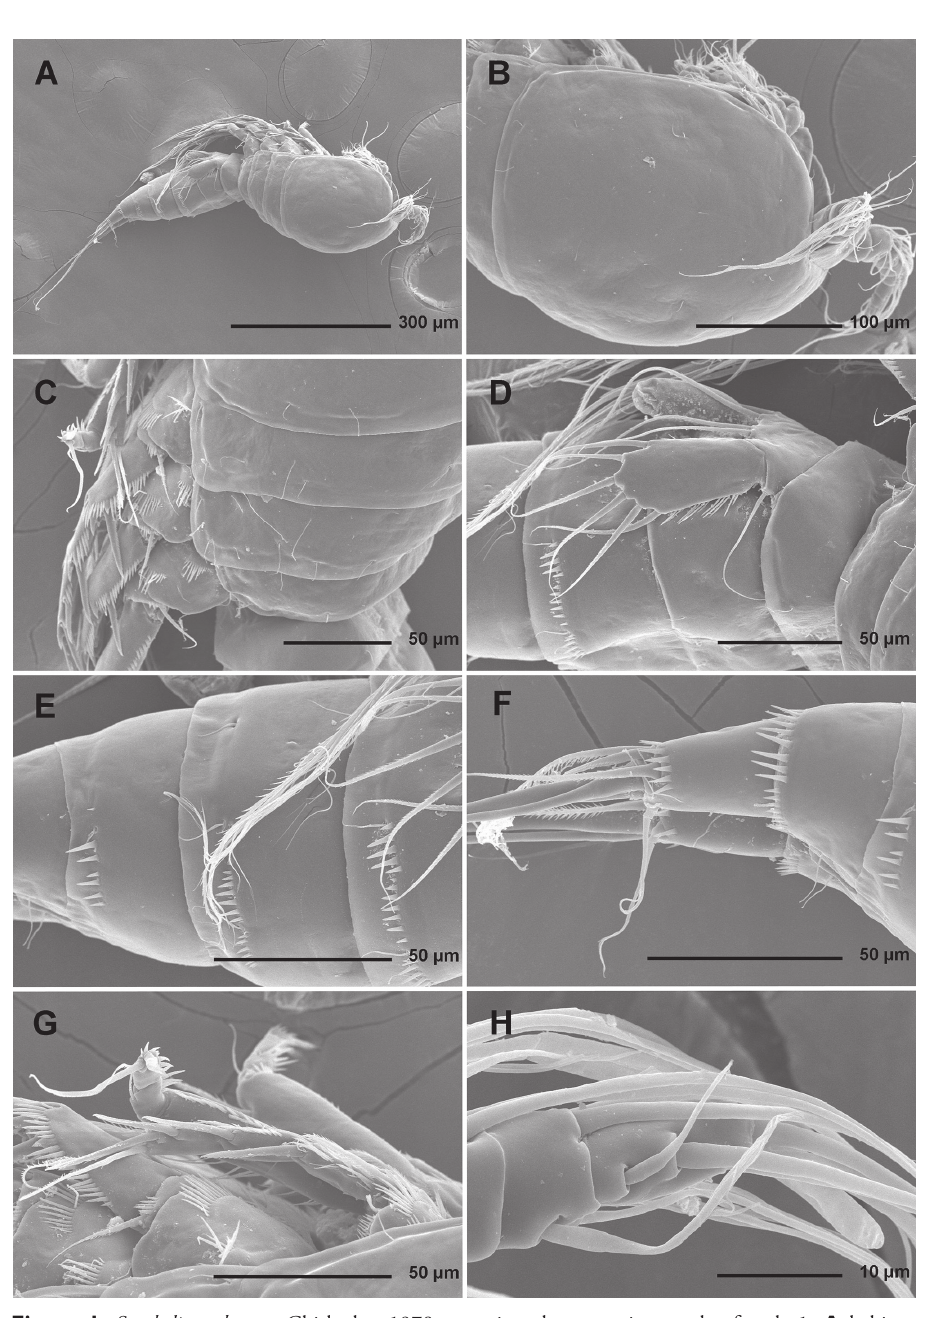
Figure 1. Stenhelia pubescens Chislenko, 1978, scanning electron micrographs, female 1: A habitus, lateral B cephalothorax, lateral C free thoracic somites, lateral D fifth pedigerous somite and genital double-somite, lateral, with one spermatophore attached on ventral side E fourth and fifth urosomites, lateral F anal somite and caudal rami, lateral G first legs and proximal part of second and third legs, lateral H distal part of right antennula,